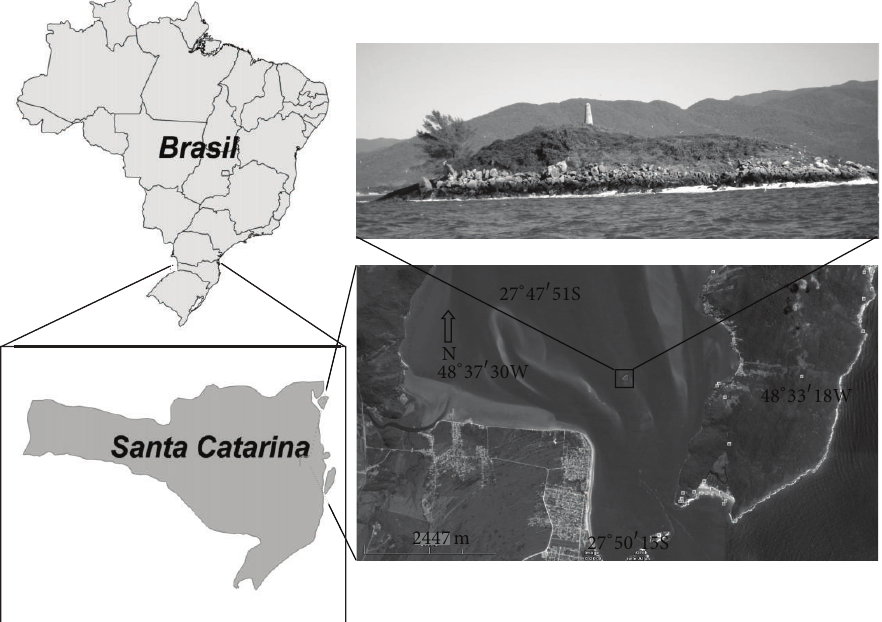
Figure 1: Map showing the study area [10].